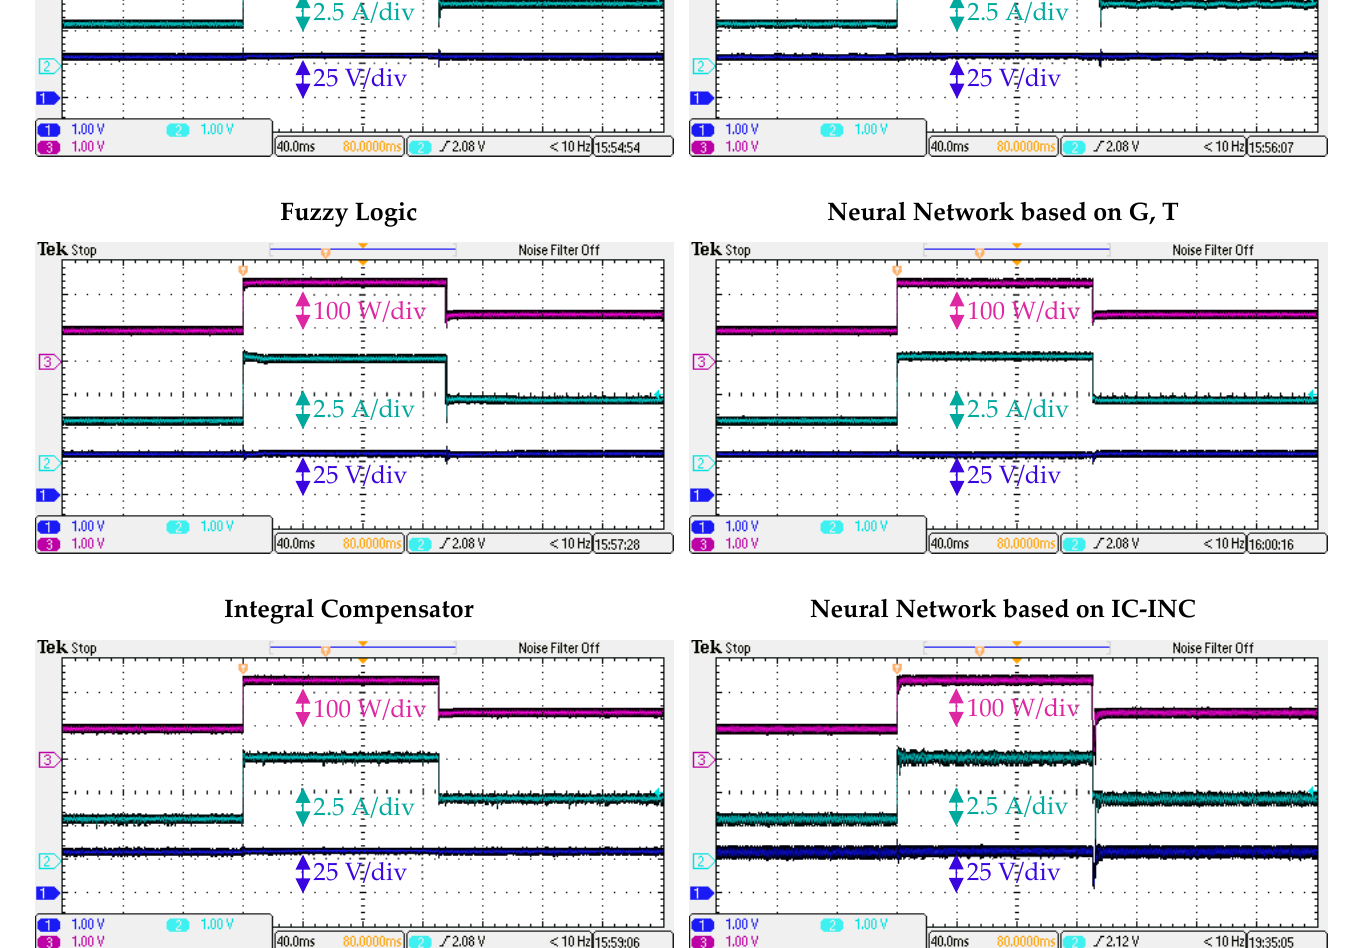
Figure 14. HIL results of power produced from panel when step variations occurred.